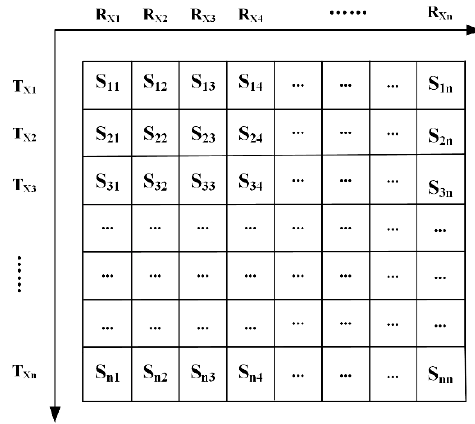
Figure 1. Full matrix data from ultrasonic phased array.